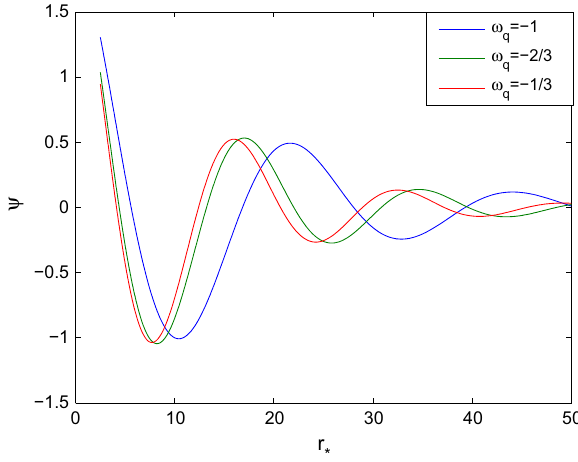
Fig. 3 Behaviorofthegravitationalperturbationfor β = 0 . 5, c = 0 . 02 and l =